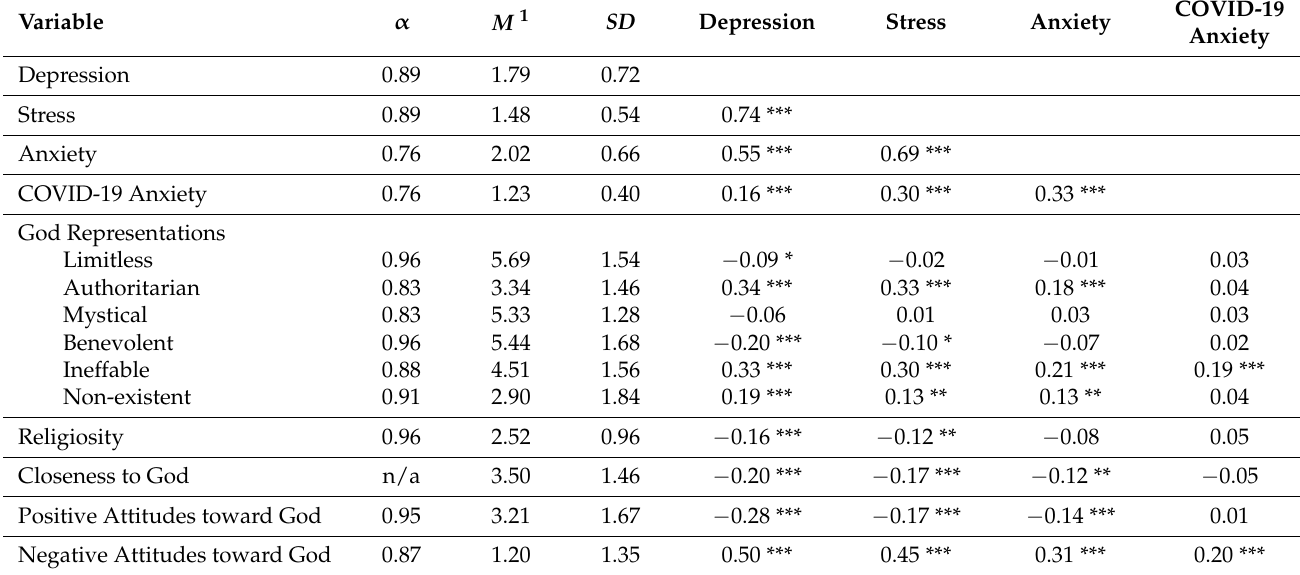
Table 1. Correlations Between Depression, Stress, Anxiety, COVID-19 Anxiety and General Religiosity, God Representations, Closeness to God, and Attitudes Toward